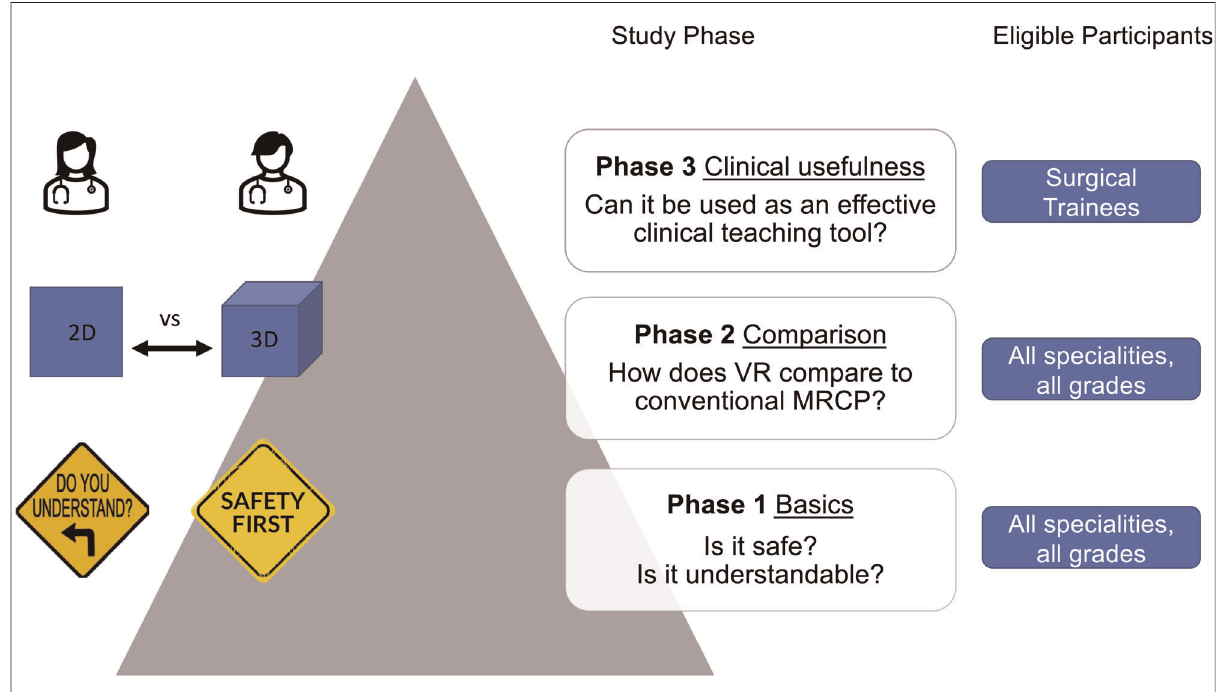
FIGURE 1 Phasewise study set up. First phase: Establishing the basics of VR MRCP experiences regarding the tolerability and overall safety of the VR experience and understanding of the displayed anatomy. Second phase: Direct comparison of conventional and VR MRCP ’ s ability to demonstrate pathological fi ndings. Third phase: Assessing the potential clinical usefulness of VR